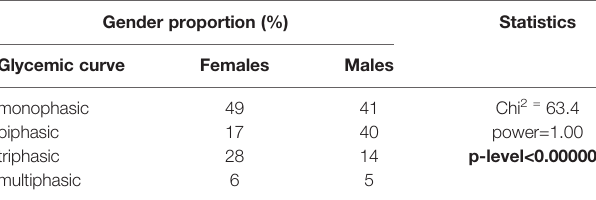
TABLE 4 | Gender proportions depending on the shape of glycemic curves. Gender proportion (%)